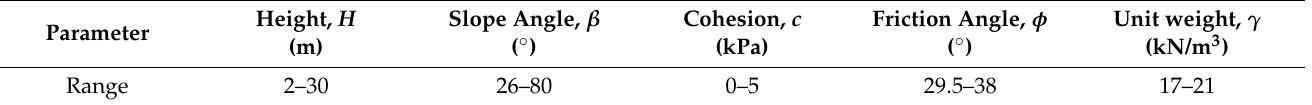
Table 1. Range of model parameters’ variation, assuming a uniform probability